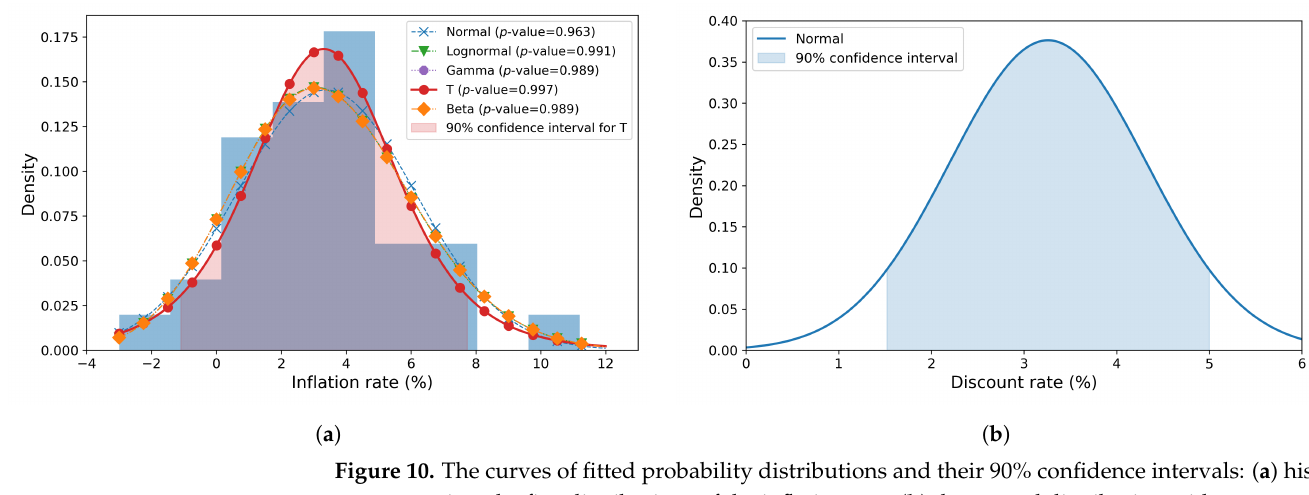
Figure 9. Historical records for the inflation rate in South Korea.